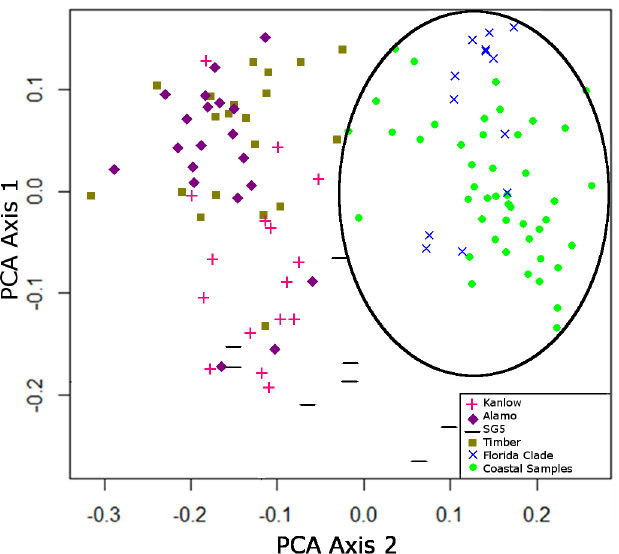
Fig 3. Principle Coordinate Analysis (PCA) of SSR markers from L4x cultivars and plants collected in the LISCL coastal ecoregion (n = 124). The circle indicates the clustering of collected LISCL plants with three L4x cultivars ( ‘ Miami ’ , ‘ Wabasso ’ , ‘ Stuart ’ ) representing the Florida Clade. Colors indicate: ‘ Kanlow ’ (red +), ‘ Alamo ’ (purple ♦ ), ‘ SG5 ’ (black-), ‘ Timber ’ (olive green & ), Florida Clade cultivars (blue×), and coastal samples (light green ● ).